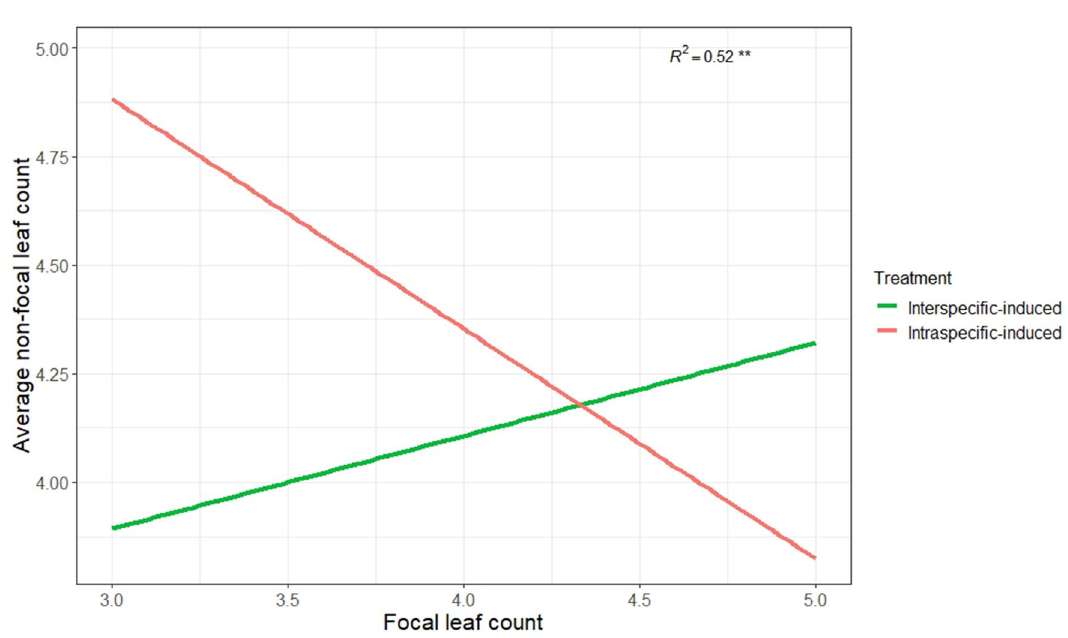
Figure 4. Relationship between Pascopyrum smithii focal plant number of leaves and the average number of leaves for the two non-focal conspecific neighbors. Significance levels are denoted by ns P > 0.5; * P ≤ 0.05; ** P ≤ 0.01; *** P ≤